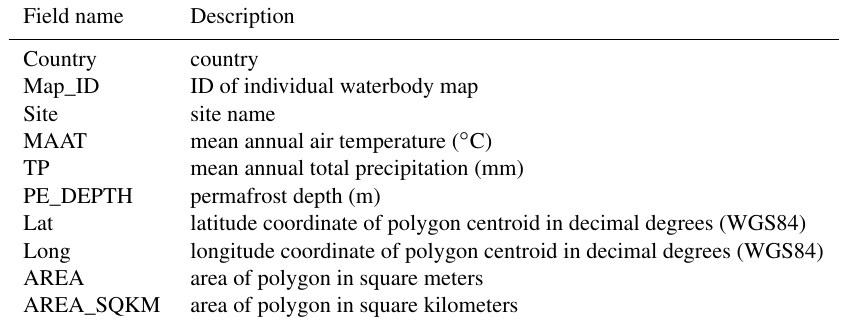
Table C2. Attributes contained in the polygon attribute table of circum-Arctic permafrost landscapes